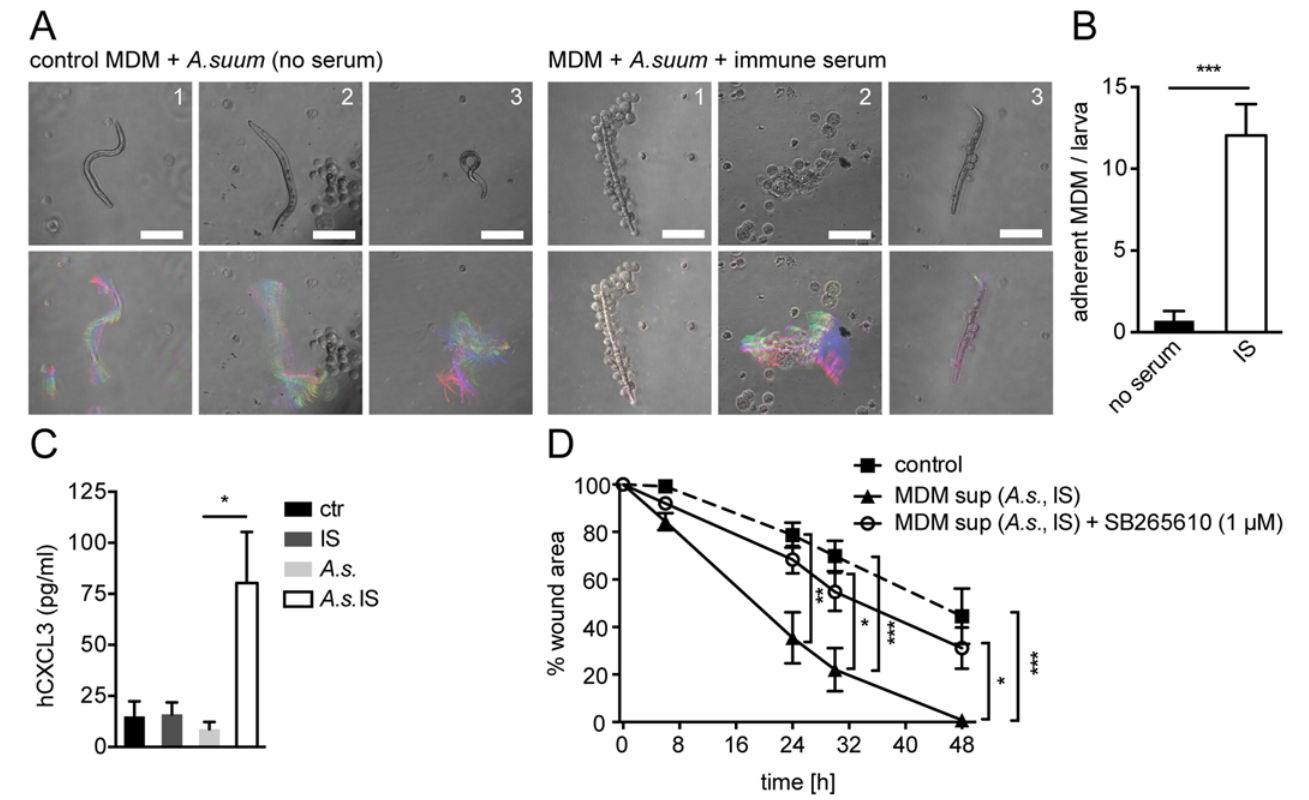
Fig 5. Conditioned media from A . suum -immune serum-activated M Φ promote in vitro scratch wound closure by human MF in a CXCR2 dependent fashion. (A) Human MDM from 3 healthy blood donors (1 – 3) were co-cultured with A . suum larvae in the absence or presence of IS from challenge- A . suum infected pigs and time-lapse movies were recorded (2 frames/ s, 1 min); upper panel: representative snap shots at T = 0; lower panel: representative temporal color code images (120 frames, 1 min) — colors represent different time points; Scale bars 100 μ m; (B) Adherent MDM per A . suum larva were counted in time-lapse movies; (C) CXCL3 in culture supernatants from human MDM cultured with or without immune sera from Ascaris -infected pigs (IS), Ascaris suum larvae ( A . s .) or both ( A . s . IS) quantified by ELISA; (D) Scratch wound closure by human MF cultured in the presence of conditioned media from MDM (MDM sup) stimulated with A . s . IS +/- the CXCR2 antagonist SB265610; All data are pooled from at least 3 independent experiments with n = 3 co- cultures in each and presented as mean +/-SEM.